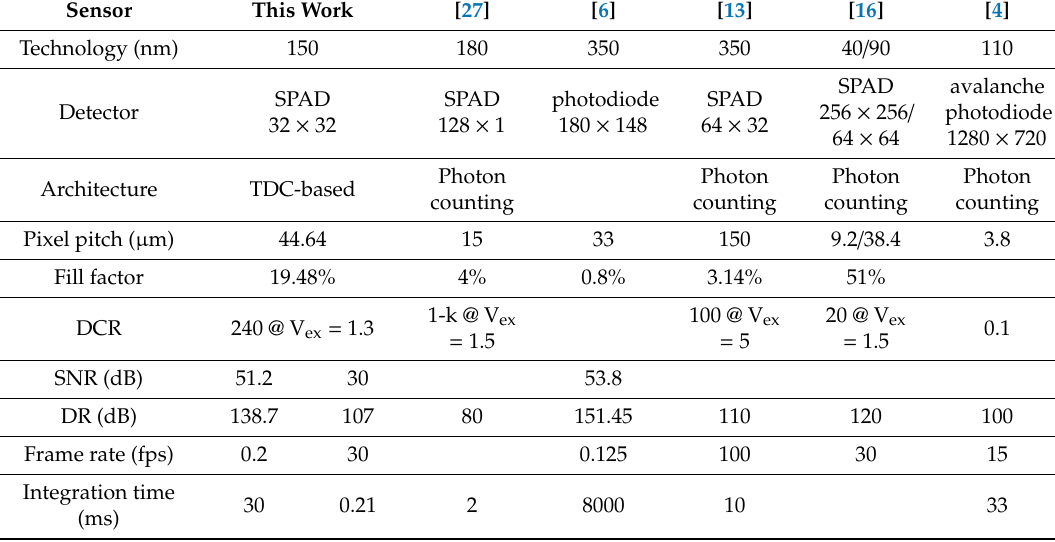
Table 1. Comparison of the high dynamic range (HDR) single-photon avalanche diode (SPAD), DCR—dark count rate; SNR—signal-to-noise